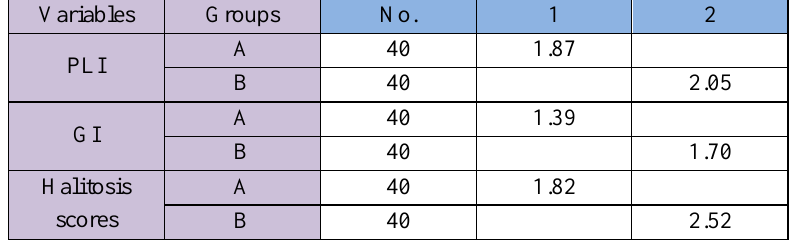
Table 5: Comparison of the means of groups according to Scheffe test at seventh examination Variables Groups No. 1 PLI